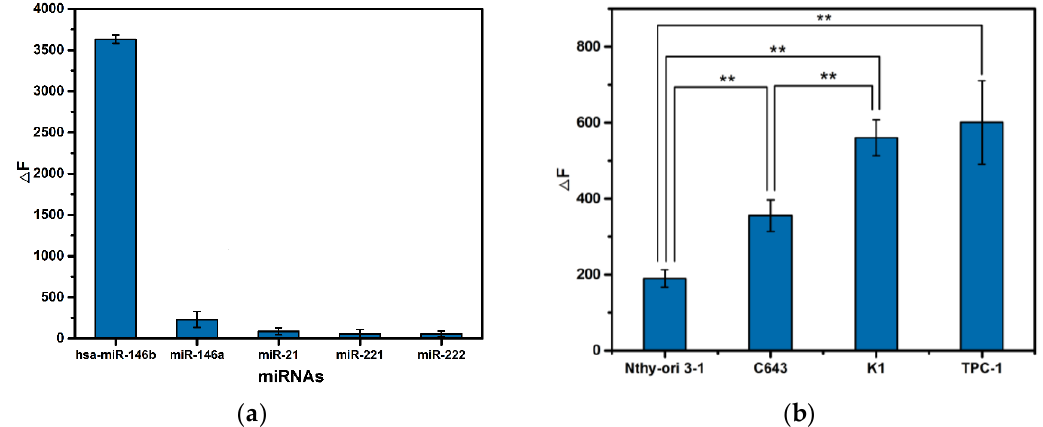
Figure 5. ( a ) Specificity of the TSDR-based flow cytometric assay. The concentrations of miRNAs are 1 nM, and ( b ) expression levels of hsa-miR-146b-5p in different cells. Error bars indicate standard deviations ( n = 3, the significance of data is analyzed according to two-sided unpaired Student’s t -test: ** p < 0.01).